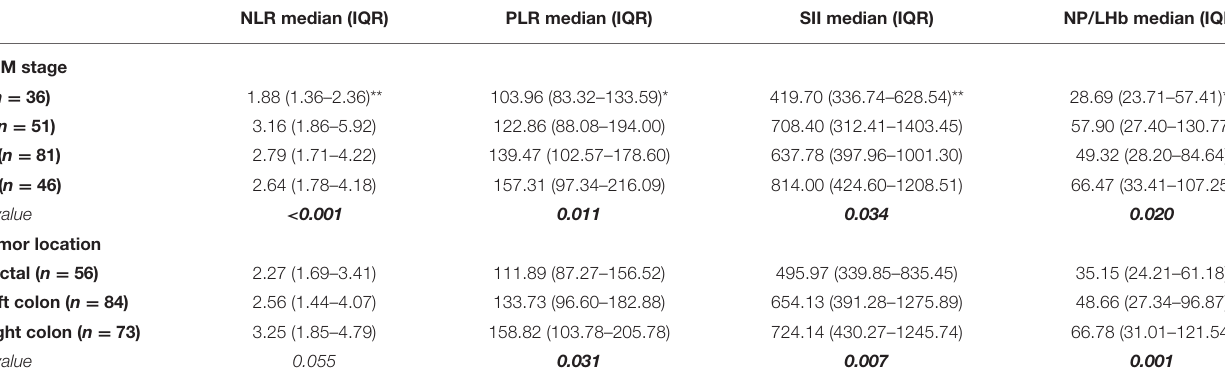
TABLE 2 | Median, interquartile range (IQR) and association of the inflammatory markers according to CRC-related variables (TNM stage and tumor